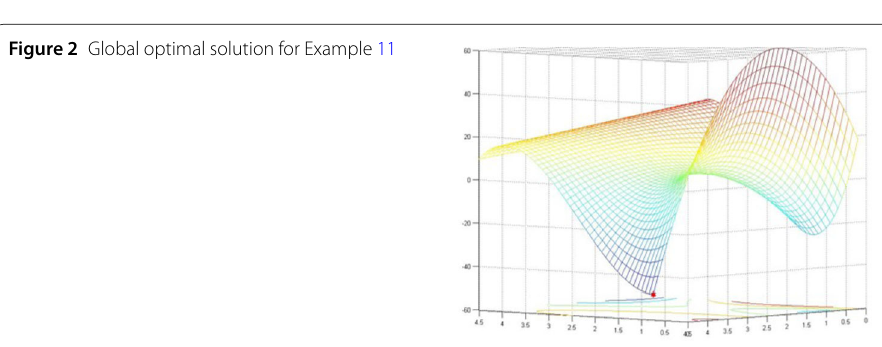
Figure 2 Global optimal solution for Example